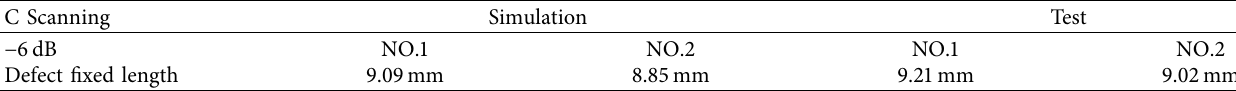
Table 4: Comparison of fixed length of defects between horizontal through holes 1 and